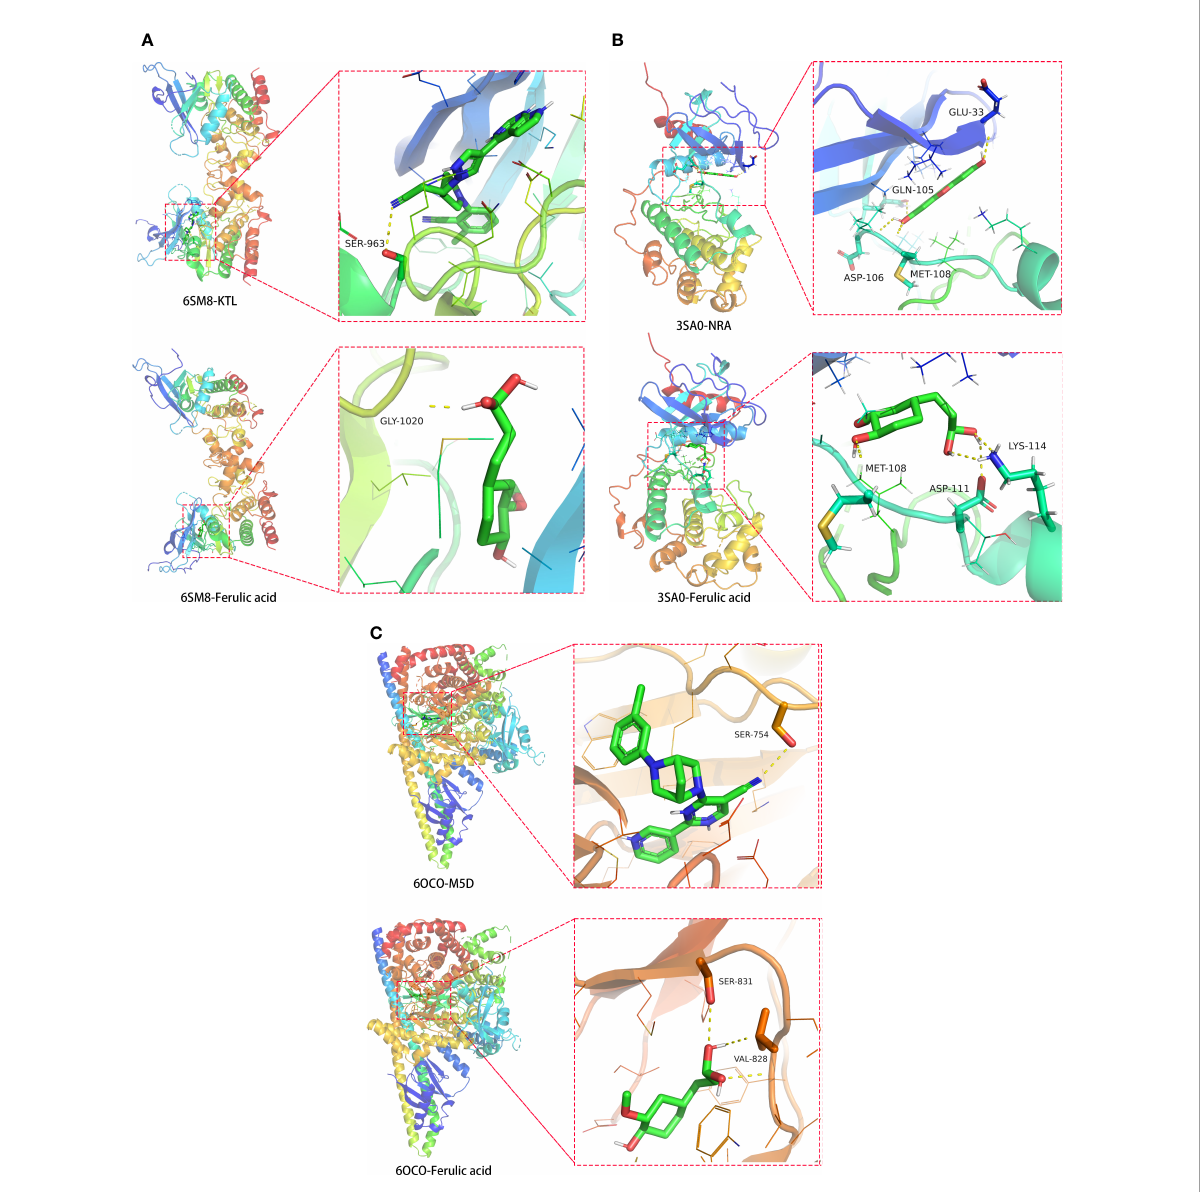
FIGURE 8 Molecular docking models of ferulic acid binding to the identi fi ed STAT3, MAPK1, and PIK3R1 target proteins with respect to (A) 6SM8, (B) 3SA0, and (C)